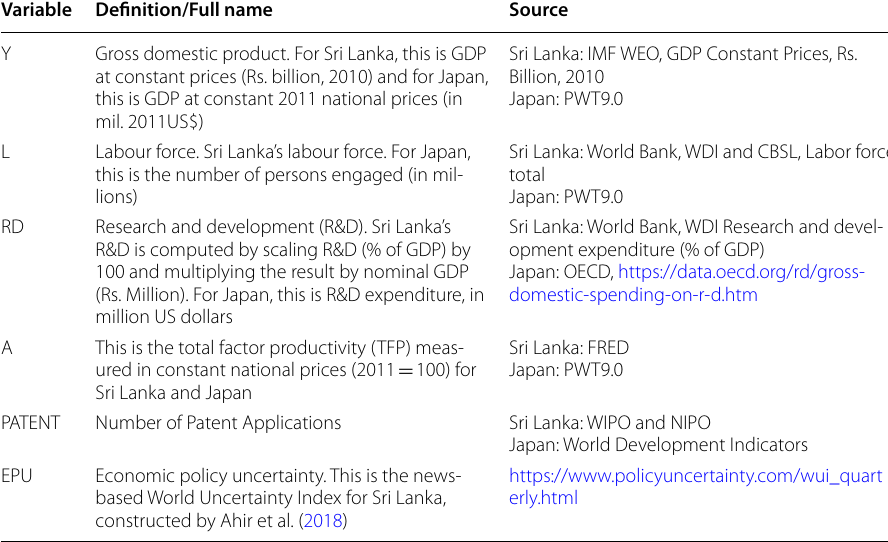
Table 6 Definitions and sources of the